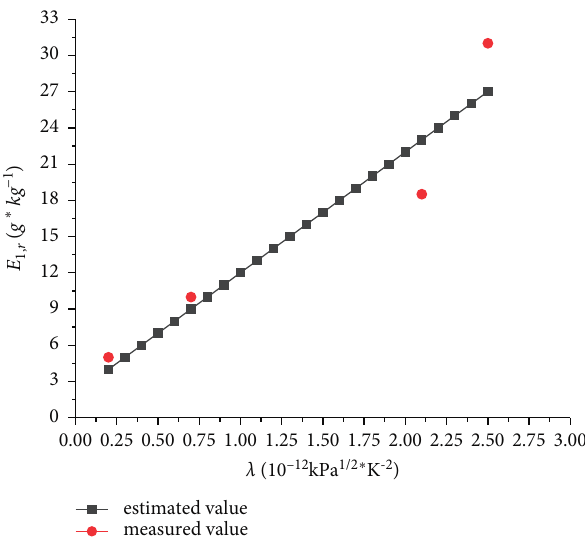
Figure 2: NOx reference emission index. E as measurement value, black box as the estimated value.